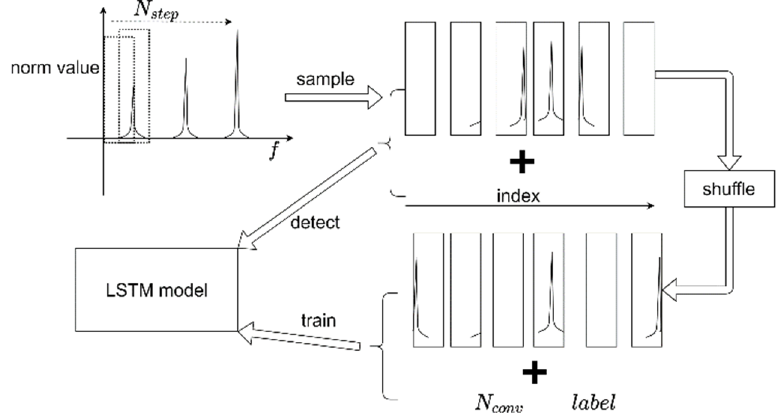
Figure 6. The training and detection